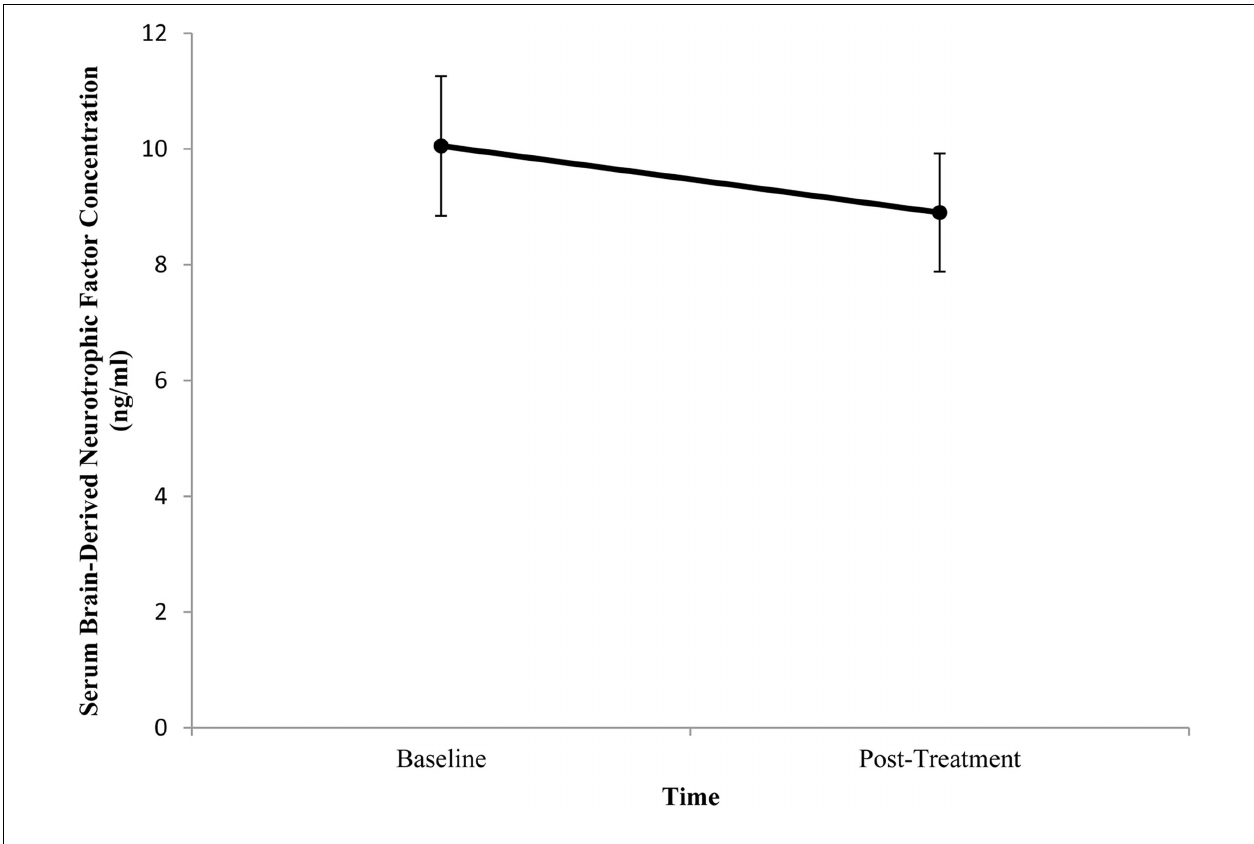
stimulation (rTMS). Serum BDNF was determined 1week prior to and 1week following rTMS.There was no significant difference between pre- and post-treatment BDNF levels ( p = 0.282).Values are mean ±